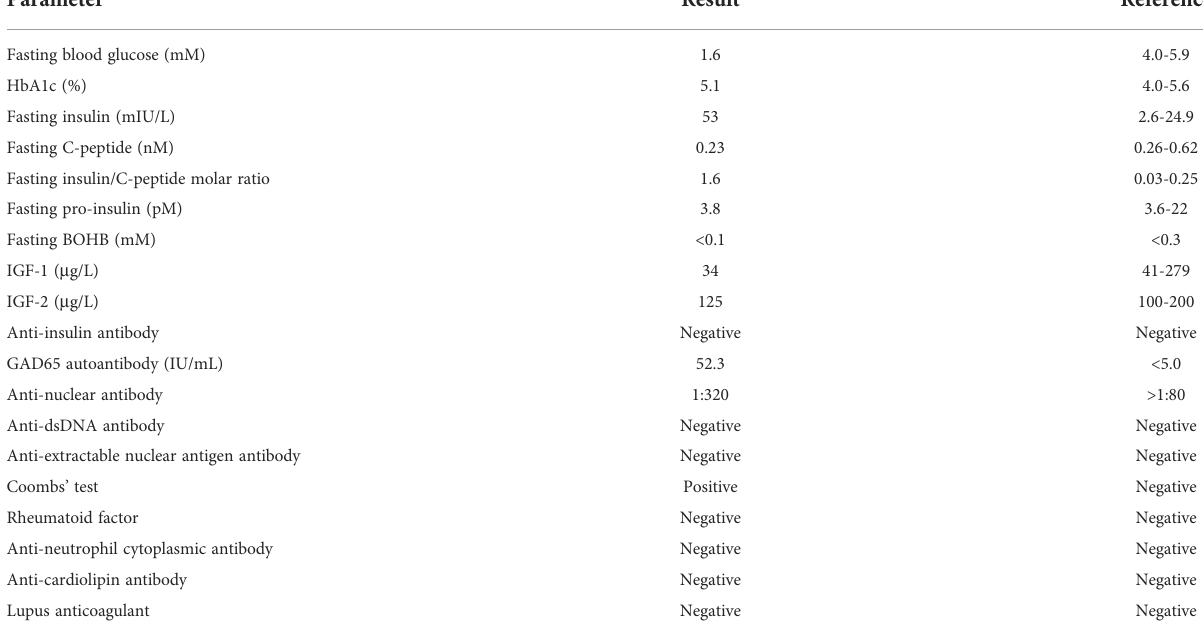
TABLE 1 Glycaemic control parameters and autoantibodies of the patient on admission.